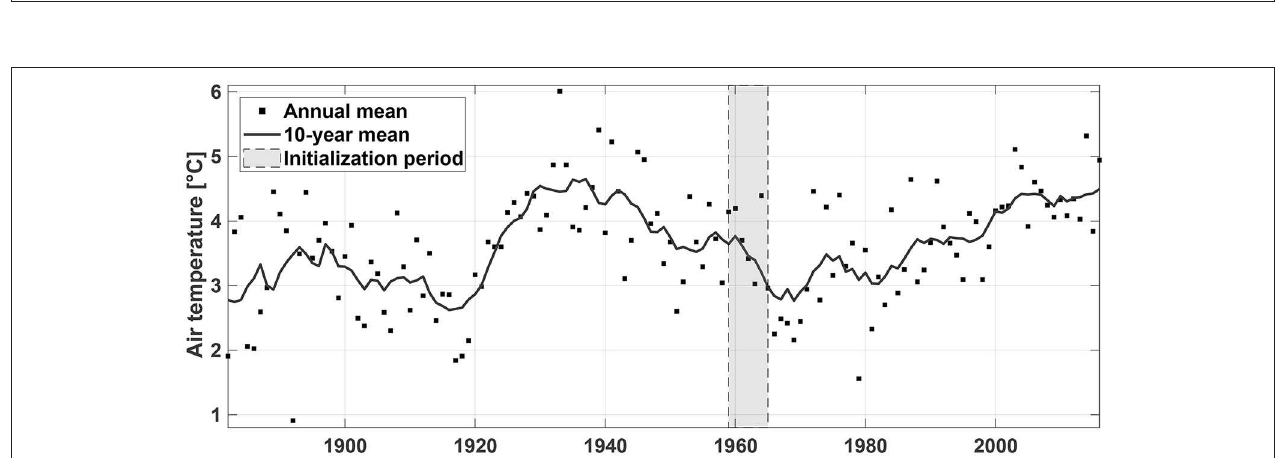
FIGURE 2 | Mean annual air temperature with a 10-year running mean in Akureyri in the period 1882–2016. Initialization period of the transient permafrost model is also shown. Data from the Icelandic Meteorological Office.